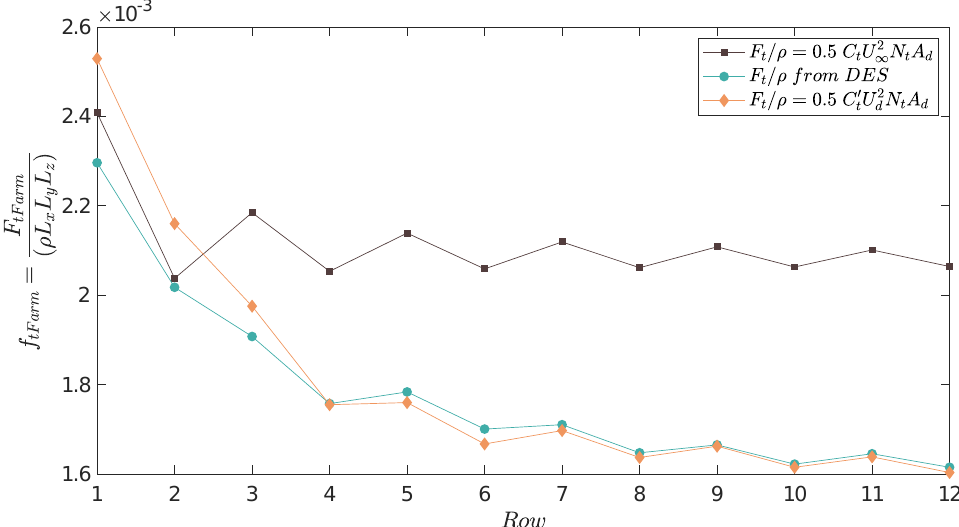
Figure 5. Resultant force calculated by using control volumes that go from the first row of turbines through the last one (see Figure 4), per unit of mass ( ρ L x L y L z ); ∎ analytic force calculated as the force of one actuator disk times the total number of devices in the farm; ⧫ analytic force calculated by using the average velocity at the location of the disks, U d , instead of the undisturbed velocity, U ∞ ; ● resultant force obtained from DES numerical